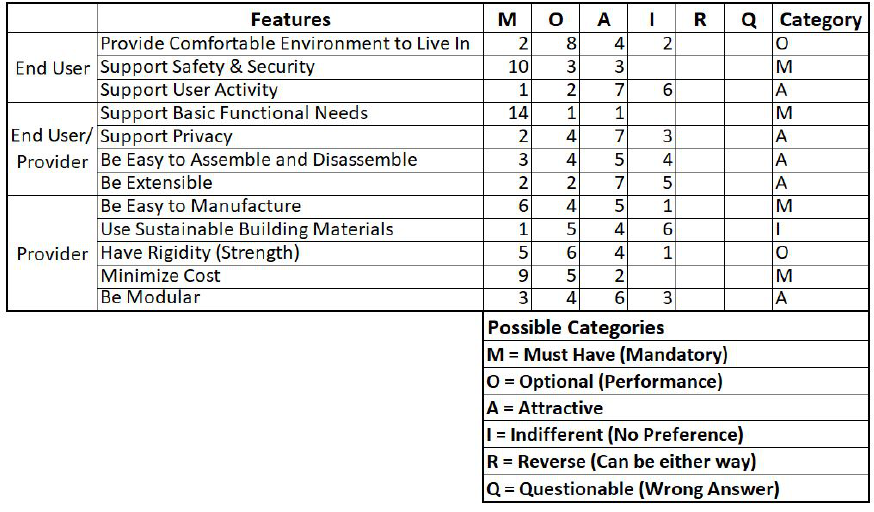
Figure 10. Kano survey results for temporary rural refugee